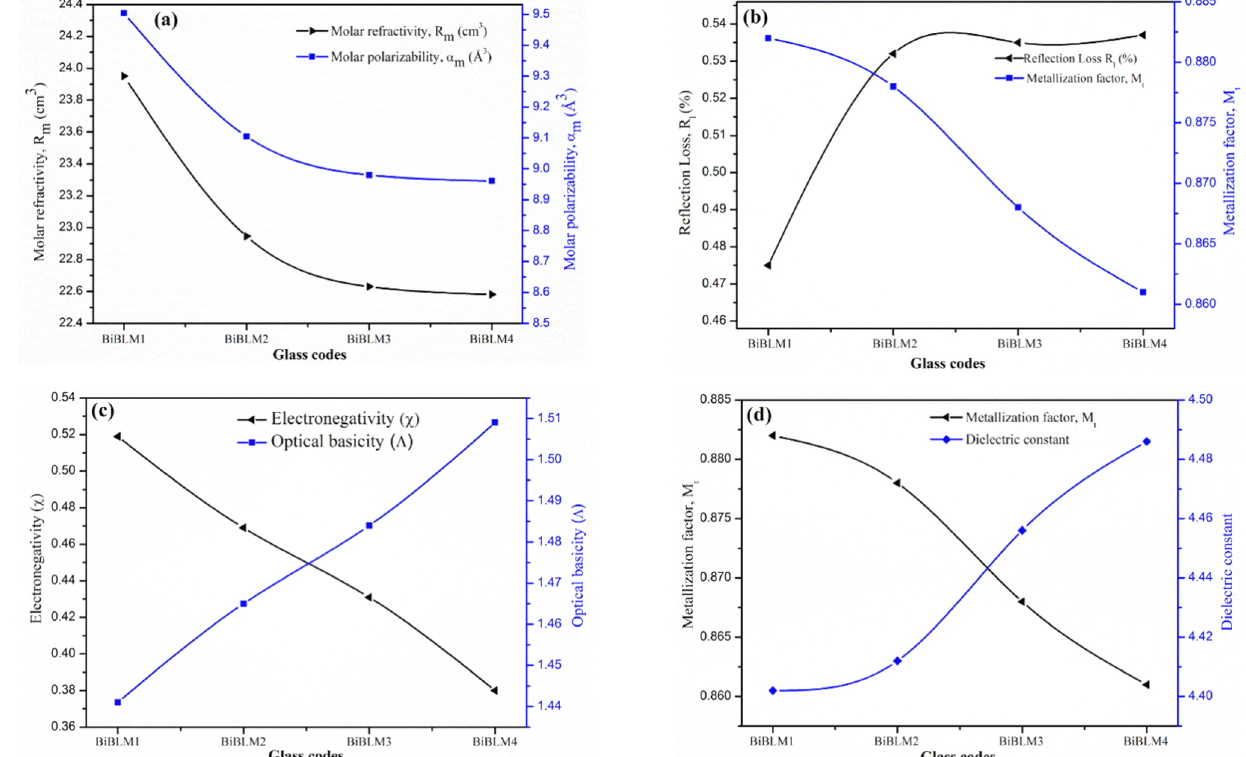
Figure 9. Dependence of ( a ) molar refractivity values ( R m ) and electronic polarizability ( α e ); ( b ) reflection loss R (%) and metallization factor (M t ), ( c ) electronegativity (χ) and optical basicity (Λ );( d ) metallization factor (M t ) and dielectric constant corresponding to BiBLM glasses.